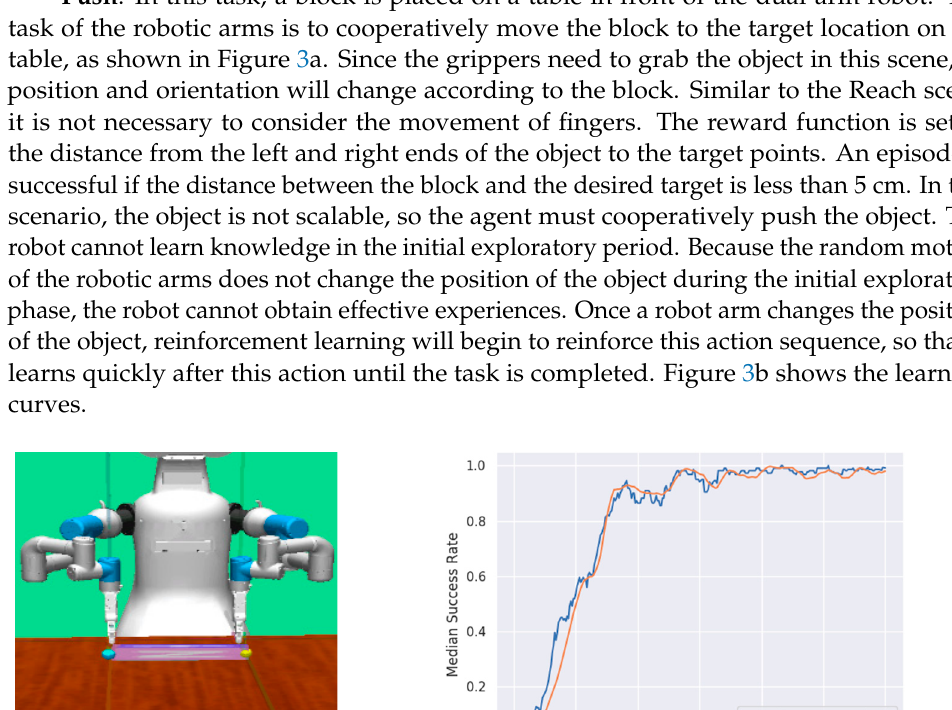
Figure 3. Push scene. ( a ) The task is to move a block placed on the table in front of the robot to the target position on the table. ( b ) The learning curve of Push scene—the abscissa is the number of training rounds and the ordinate is the average success rate of 10 tests.